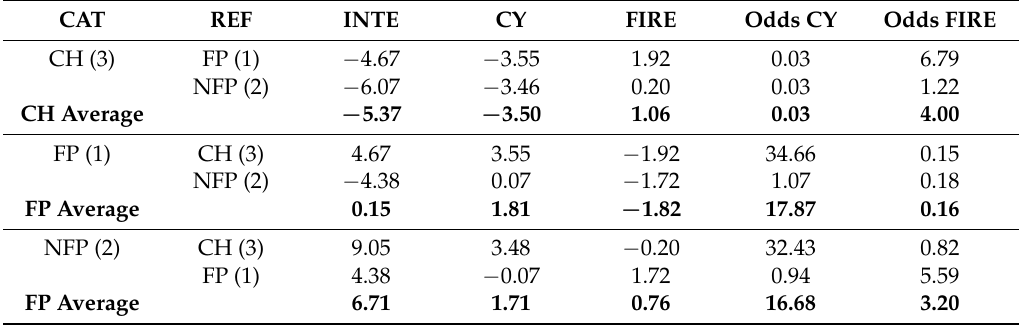
Table 2. Spatial multinomial logit model summary of trends. FP = forest persistence, NFP = non forest persistence, CH = change, INTE = Intercept, Odds = Odds ratio effects point estimates. This table contains only FIRE and CY variables, the full variable list is available in the Appendix